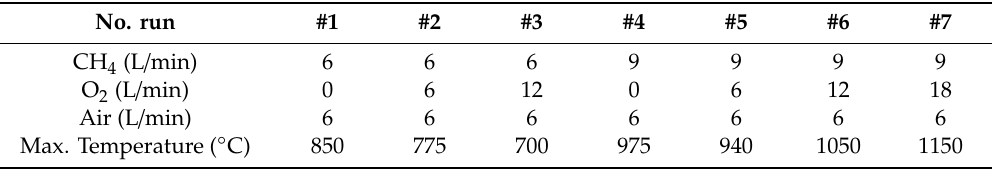
Table 1. Gas compositions of di ff erent flame